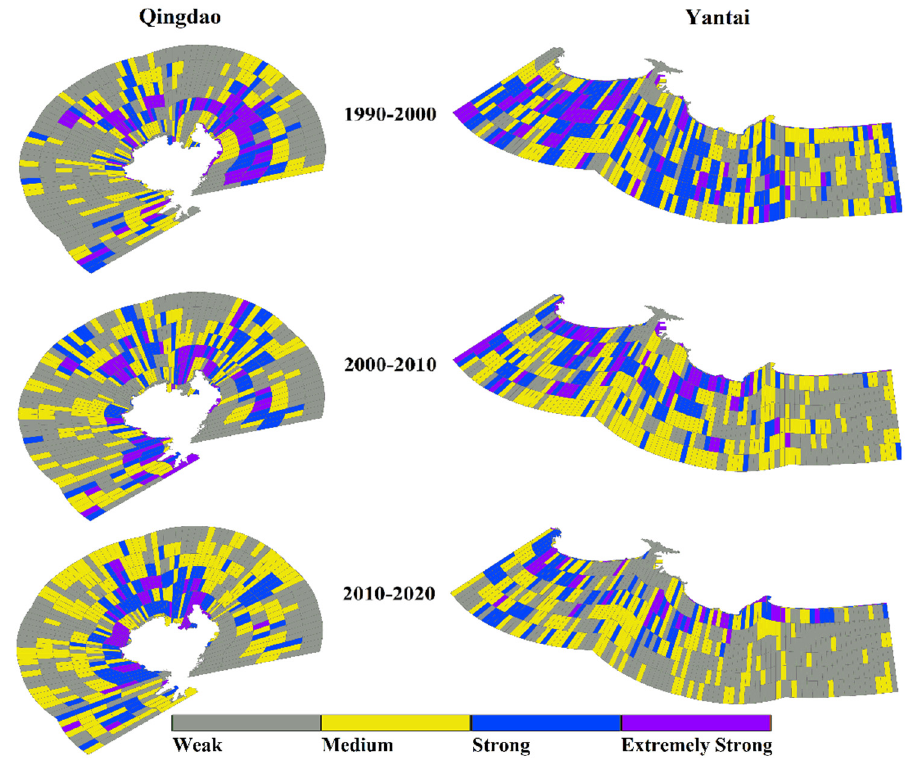
Figure 3. Distribution of the LDI in the study areas of Qingdao and Yantai.